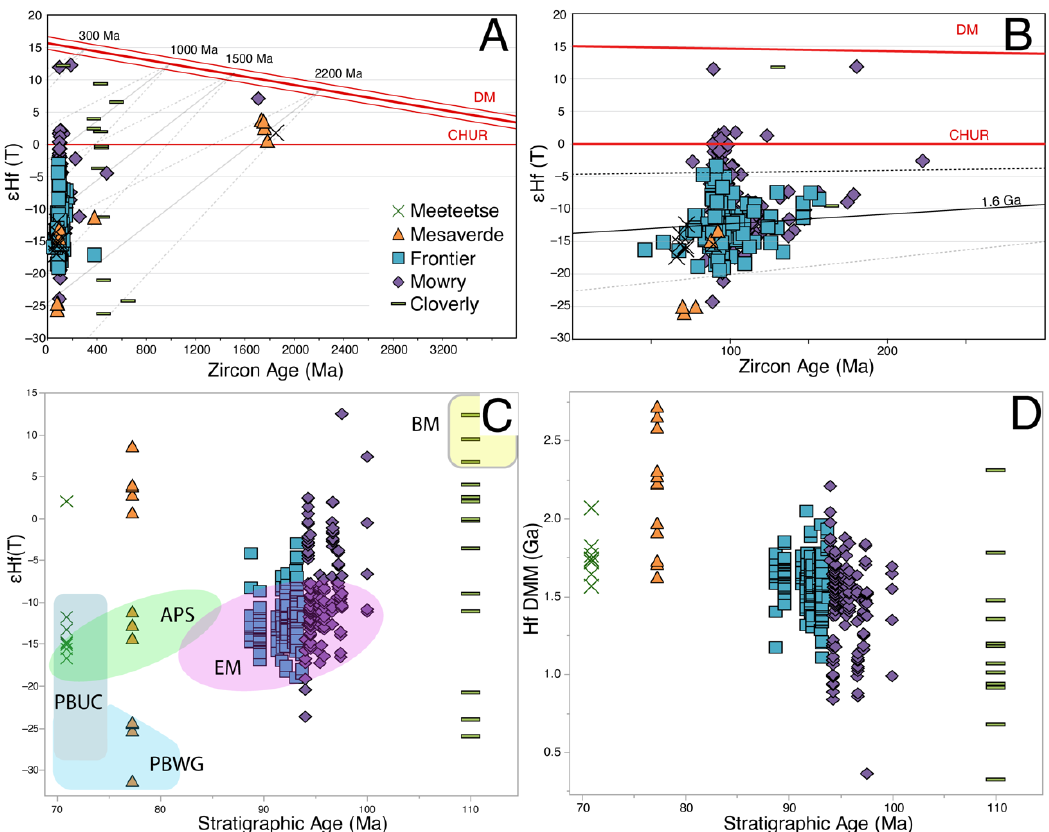
Figure 6. Zircon Hf isotopic data. Hf isotopes were analyzed on the same targets as U-Pb analysis with a larger, 60-micron spot. ( A ). ε Hf corrected for the determined age of each analysis. Tie lines show potential depleted mantle model ages for groups of zircon; 176 Lu/ 177 Hf of tie lies = 0.0036 (upper), 0.015 (middle) and 0.0193 (lower). ( B ). ε Hf data focused on the Cretaceous-aged grains. The 1.6 Ga modeled age line ( 176 Lu/ 177 Hf = 0.015) is plotted. ( C ). ε Hf(T) versus stratigraphic age. Colored polygons indicate literature data of magmatic zircon. BM = Blue Mountains [68]; EM = Early Metaluminous Suite [26]; APS = Atlanta Peraluminous Suite [26]; PBWG = Pioneer Batholith Western Granite [69]; PBUC = Pioneer Batholith Uphill Creek [69]. ( D ). Calculated Hf DMM versus stratigraphic age. See text for